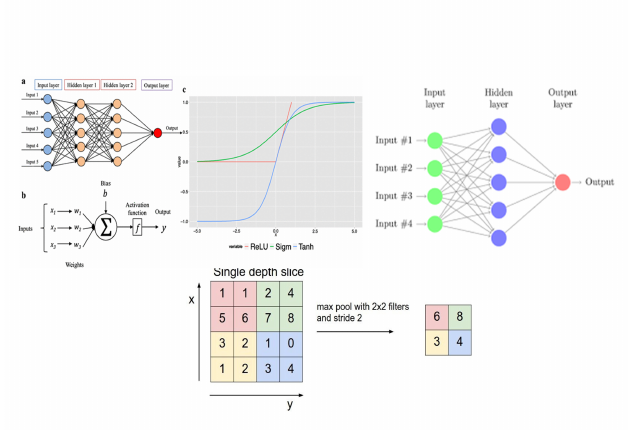
Figure 10: a. Neural Network Layer, b. Inputs, weights, bias, activation function and output, c. Plot difference between ReLU, sigmoid and Tanh, d. Hidden layers, e. Depth slicing with 2*2 max pooling kernel window and stride